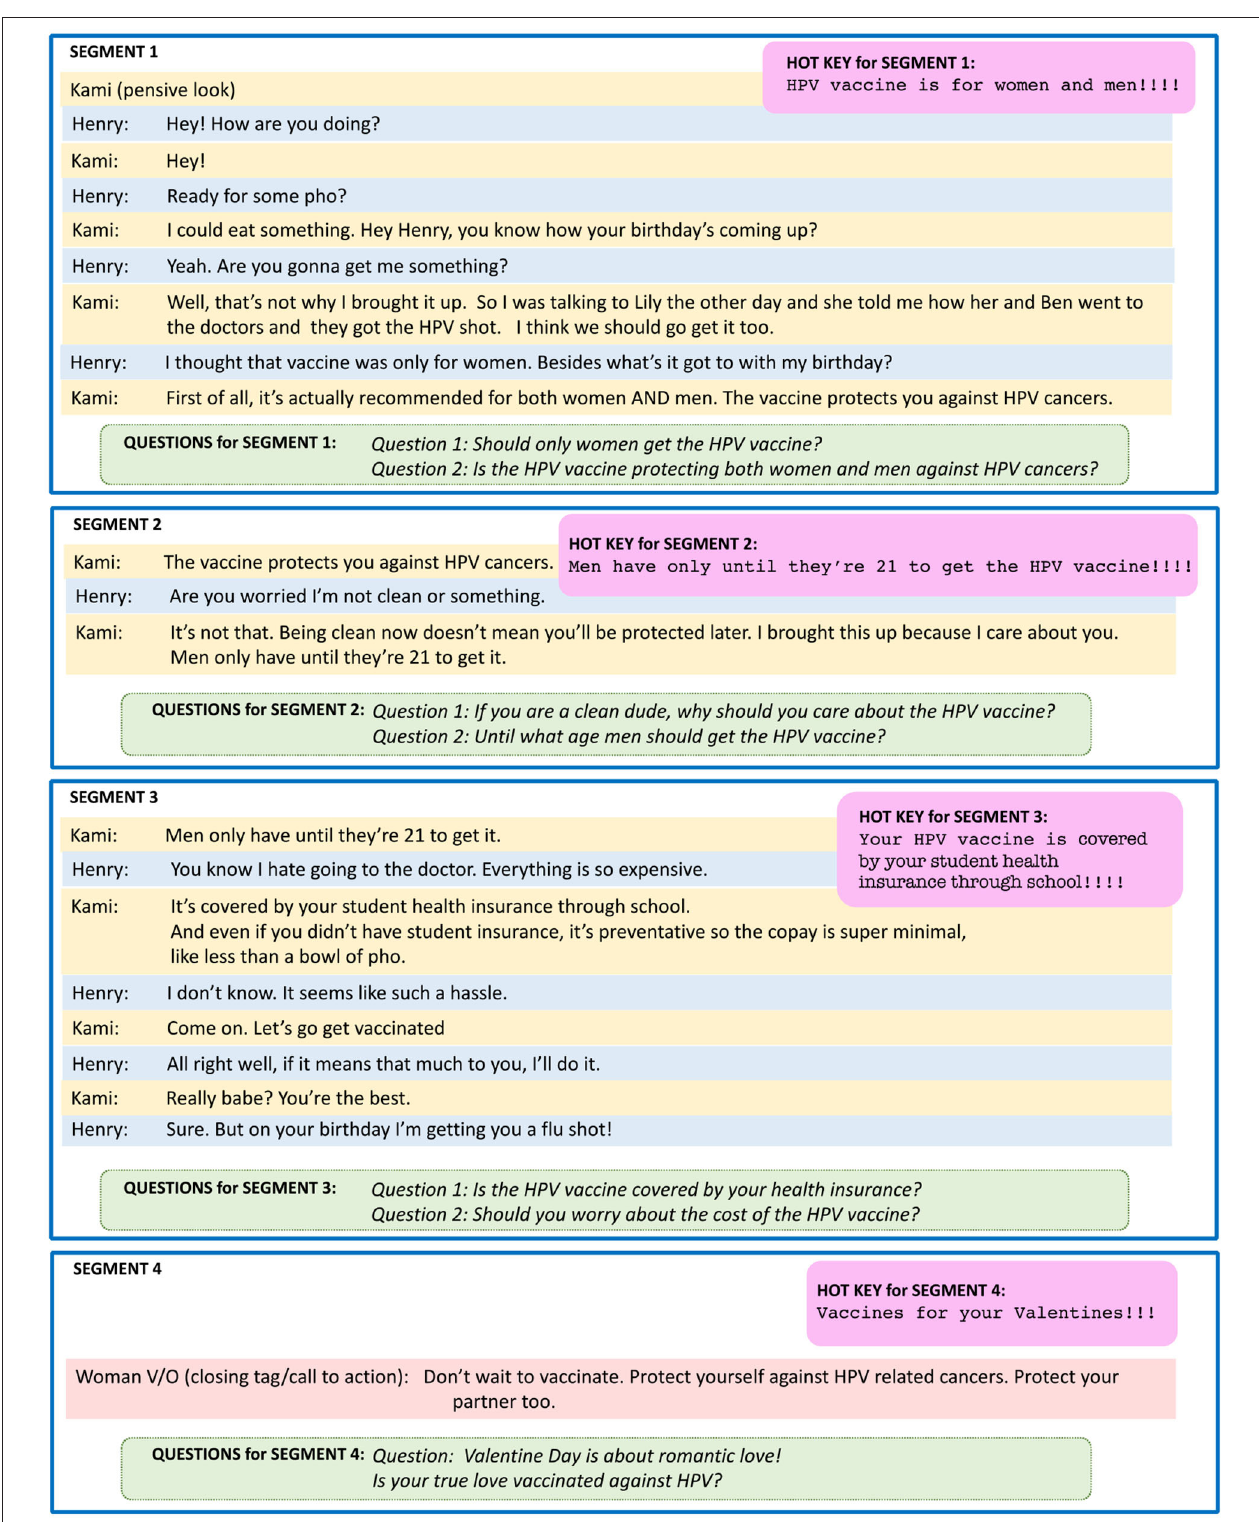
FIGURE 2 | Example of the segmentation of an EBCCP HPV video, showcasing the hot keys and questions associated with each segment.